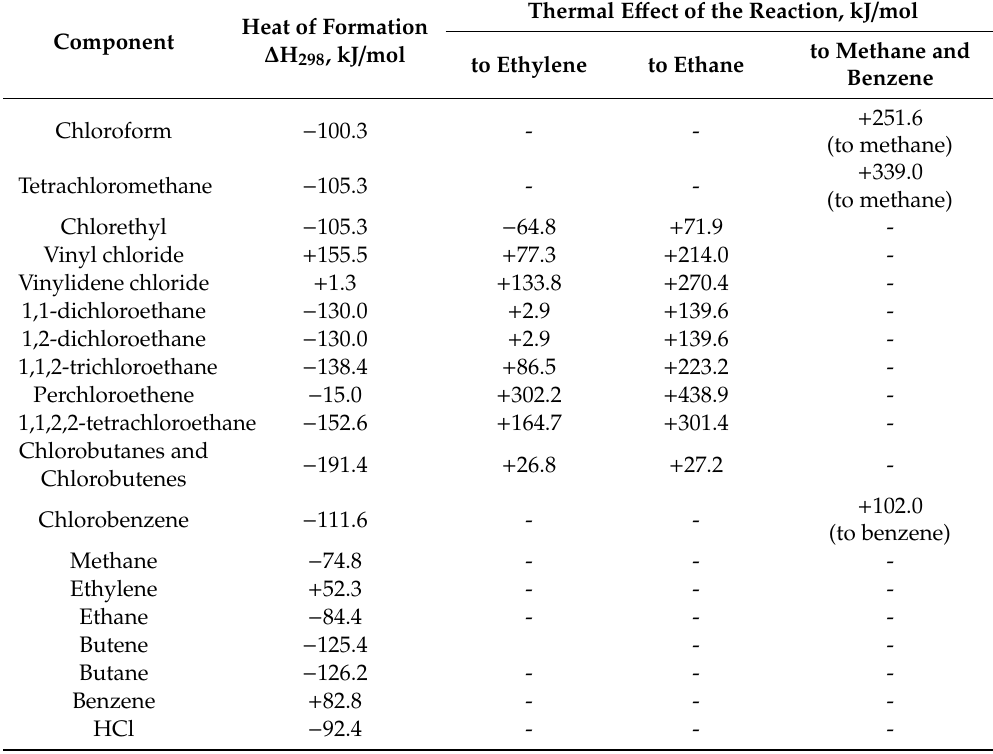
Table 1. Standard heats of formation of waste components and products of their conversion, as well as thermal e ff ect of hydrodechlorination reactions. Thermal E ff ect of the Reaction, kJ / Heat of Formation Component ∆ H / mol 298 , kJ